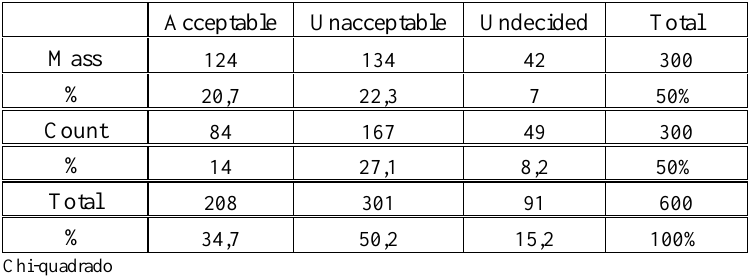
Table III: Crosstab between count/ mass vs. judgments of the second experiment Acceptable